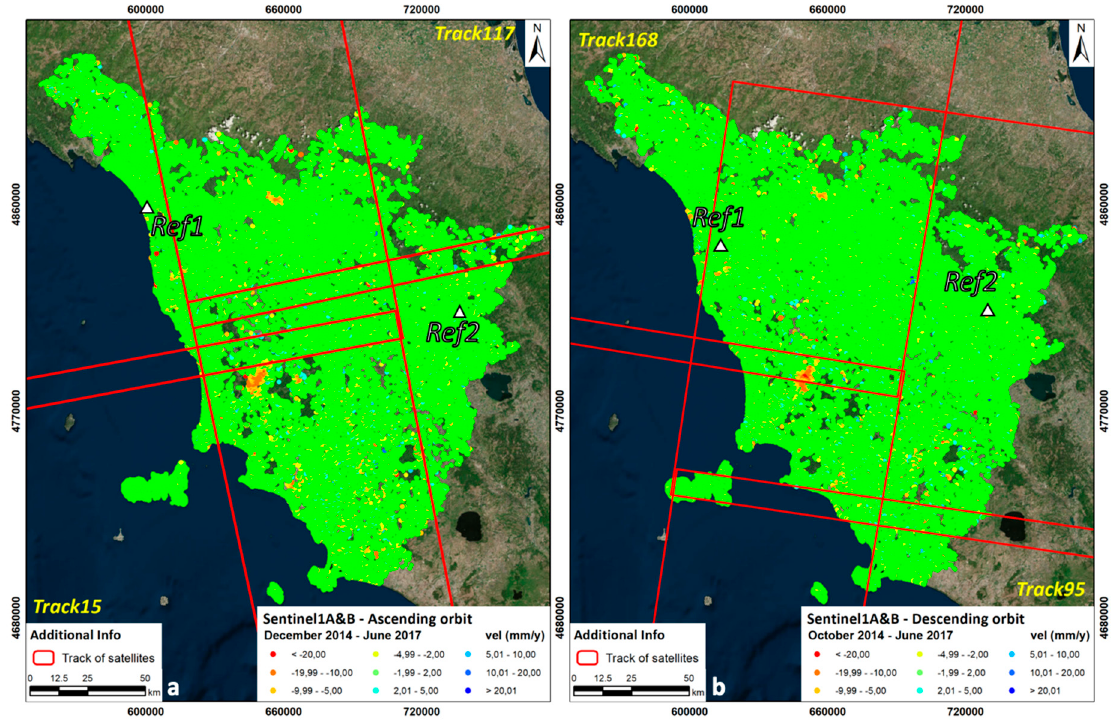
Figure 6. Ascending ( a ) and descending ( b ) deformation maps obtained by the SqueeSAR processing of Sentinel-1 images. Movements towards the satellite are highlighted in cold colours, whereas displacements away from the satellite are displayed in hot colours. The stability range is equal to ± 2 mm / yr (green points). Table 4. MP and APs of ground deformation maps for each update of the monitoring